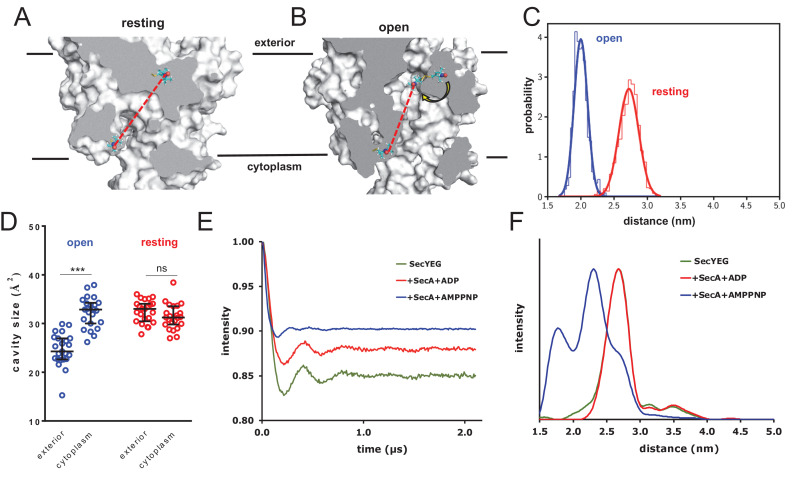
Combined EPR and MD supports nucleotide-driven cavity resizing.(A) Snapshot from the resting spin-labelled SecYEG simulation, showing the protein as grey surface and slabbed to show the interior of the channel. The spin label carbons are shown as cyan sticks, with the spectroscopically-relevant NO group in blue and red spheres. The disulphide bond to the SecY cysteine residues is shown in yellow. A predicted DEER distance is shown as a red line. (B) As panel A, but of the open channel. Upon channel widening, the MTS is able to flip into the channel (yellow arrow), resulting in a much shorter predicted DEER distance C) Histograms of intra-MTS distance data for the resting MD simulation (red) and the opened simulation (blue), overlaid with a normal distribution. The x-axis has been set as per panel F. (D) HOLE cavity analysis of the open and resting channel with MTS labels attached. The systems based on the open structure exhibit an asymmetry with respect to cavity size (blue data), whereas simulations based on the closed PDB exhibit no asymmetry (red). (E) Background corrected DEER time traces of spin-labelled SecYEG alone (green) and with excess SecA in the presence of either ADP (red) or AMPPNP (blue). The dipolar coupling between the nitroxide spin labels is evident in all three traces as modulations on the intensity of the detected spin-echo. This is almost the same for the spin-labelled SecYEG with SecA/ADP or without. (F) Distance distributions obtained from DeerAnalysis2016 (Jeschke et al., 2006) from the DEER time traces shown in E. The results for spin-labelled SecYEG with SecA and AMPPNP are, on average, at a shorter distance with a broader distribution than the overlapping distance distributions for spin-labelled SecYEG alone or with SecA/ADP. More information on the implementation of DeerAnalysis is given in the Supporting Information.